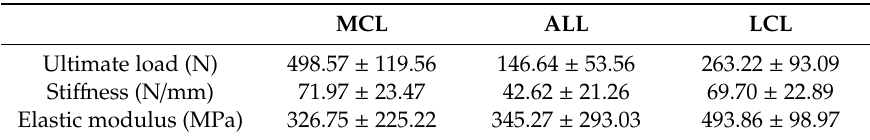
Table 3. Test results of the mechanical properties of the ligaments.